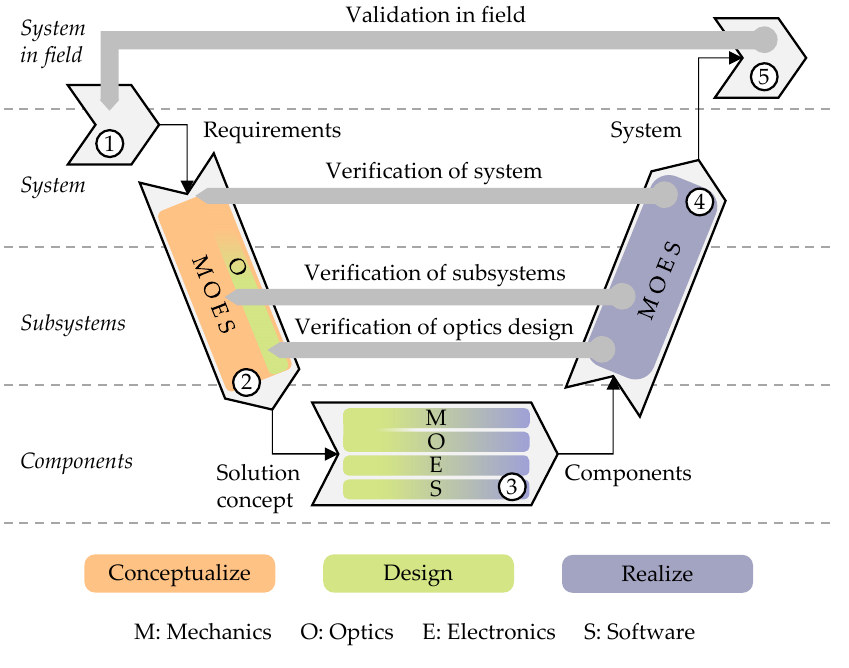
Figure 5. V-Model to develop optomechatronic systems according to